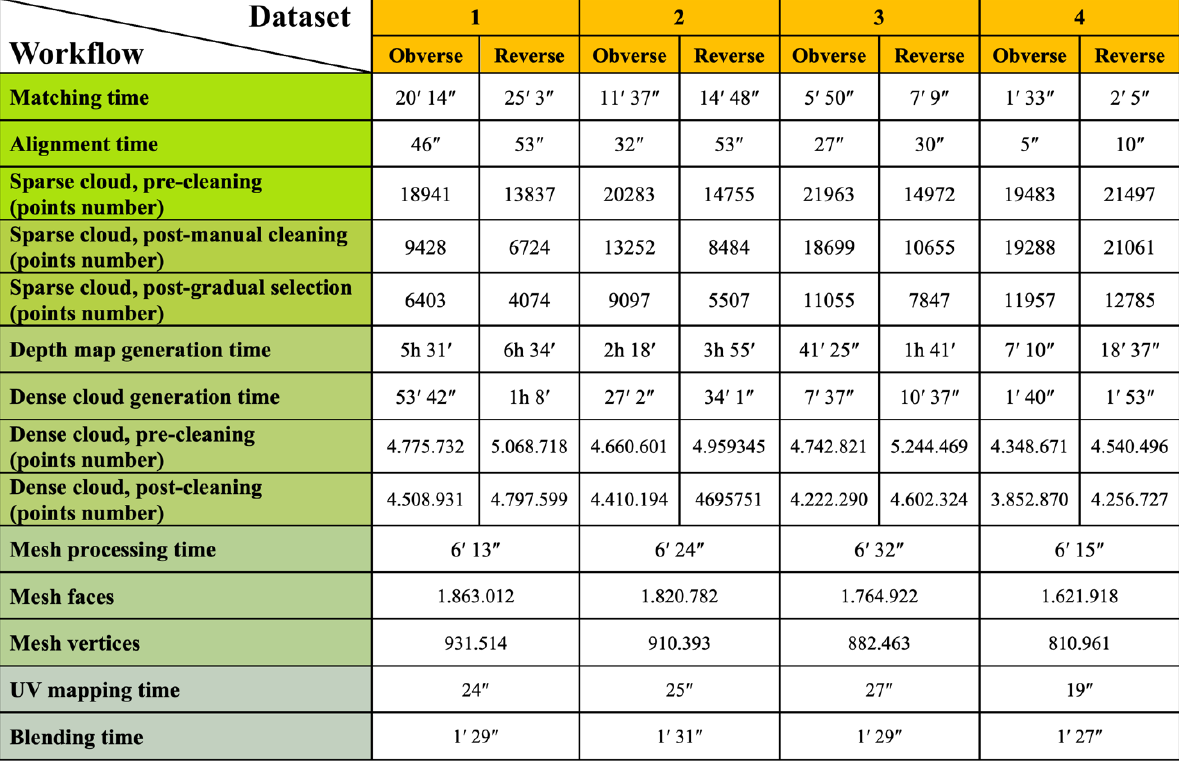
Table 9. Parameters and timing values referred to the entire photogrammetric workflow: Alignment; Gradual